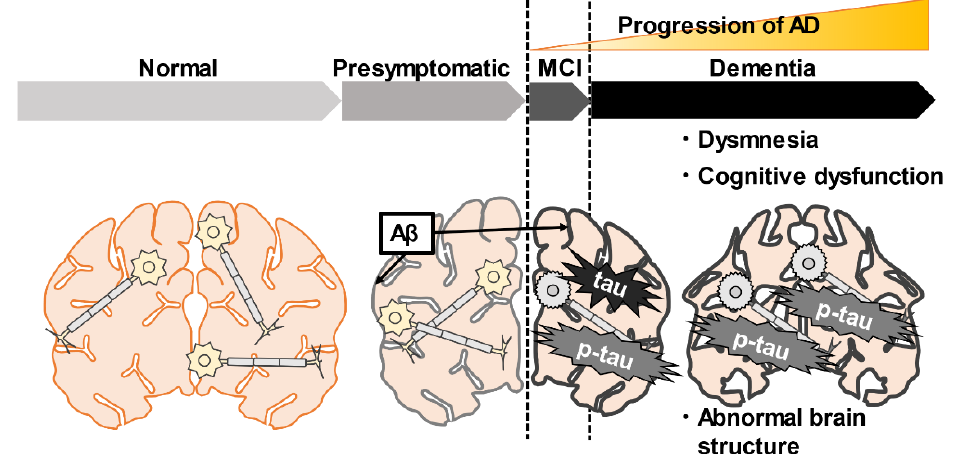
Figure 1. The pathogenesis and temporal changes of Alzheimer’s disease (AD). AD is characterized by the accumulation of amyloid-beta (A β ), tau, p-tau, brain atrophy, and cognitive decline. Accumulation of A β occurs gradually from the presymptomatic period. In the mild cognitive impairment stage (MCI), A β deposits and tau-mediated neuronal damage, and short-term memory problems progress gradually. In the dementia stage, A β deposit and tau-mediated neuropathy further structural abnormalities of the brain and memory impairment occurs. The black lines indicate the accumulation of A β in the brain.